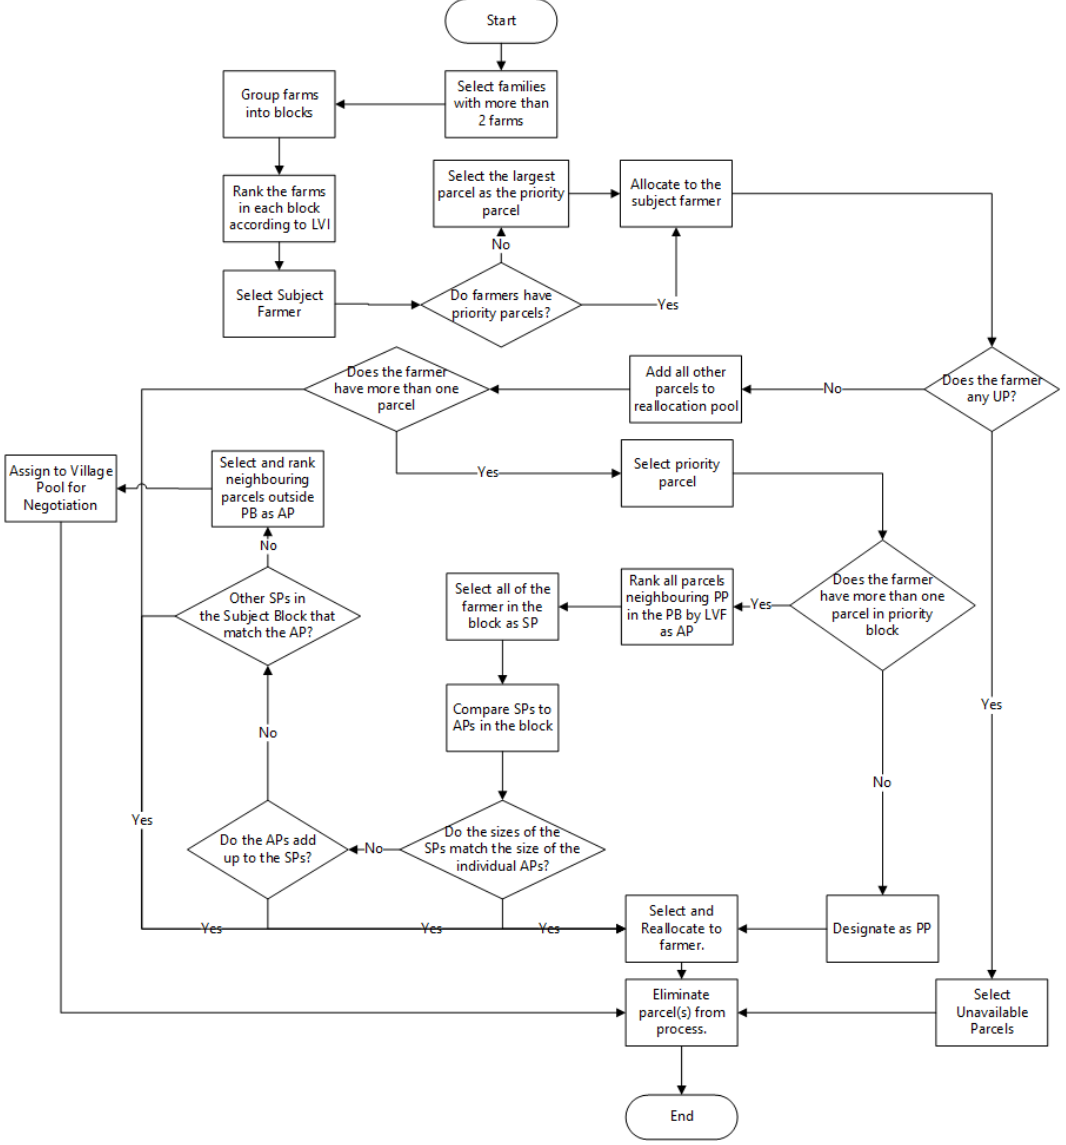
Figure 8. Flowchart of the land reallocation framework for customary lands.